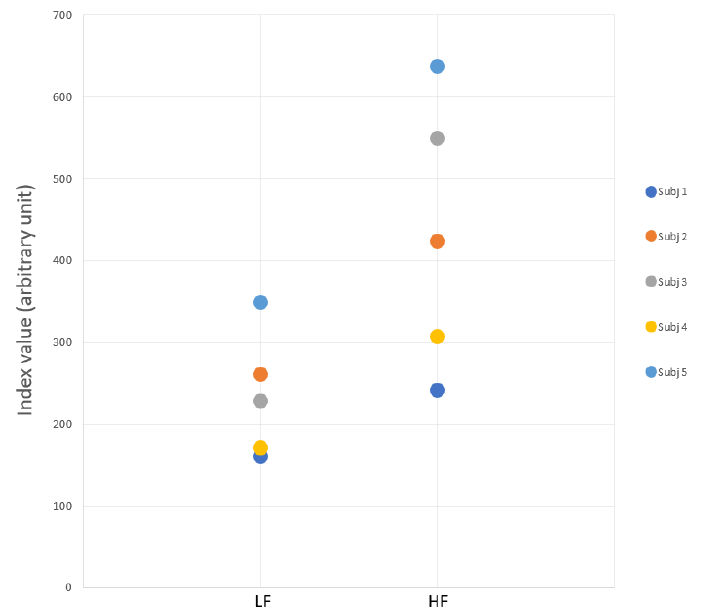
Figure 7. A typical dispersion of the average values of the LF/HF indexes for the 5 subjects, on task 1.